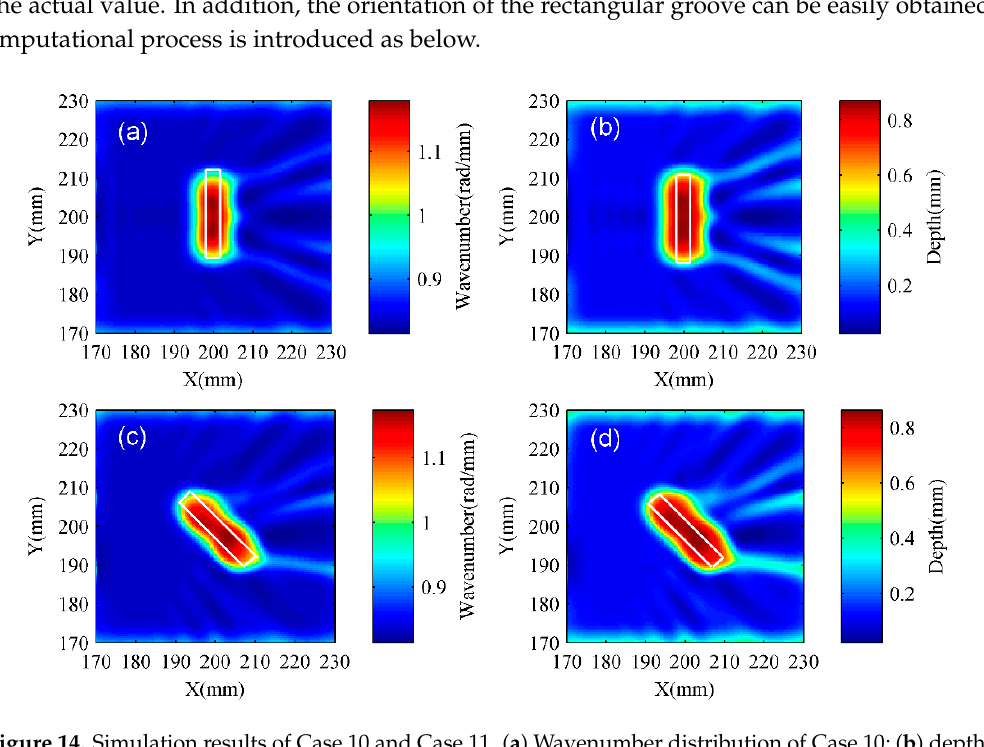
Figure 14. Simulation results of Case 10 and Case 11. ( a ) Wavenumber distribution of Case 10; ( b ) depth distribution of Case 10; ( c ) wavenumber distribution of Case 11; ( d ) depth distribution of Case 11. The white rectangle represents the actual location of the damage. The actual depth of the defect is 1 mm.